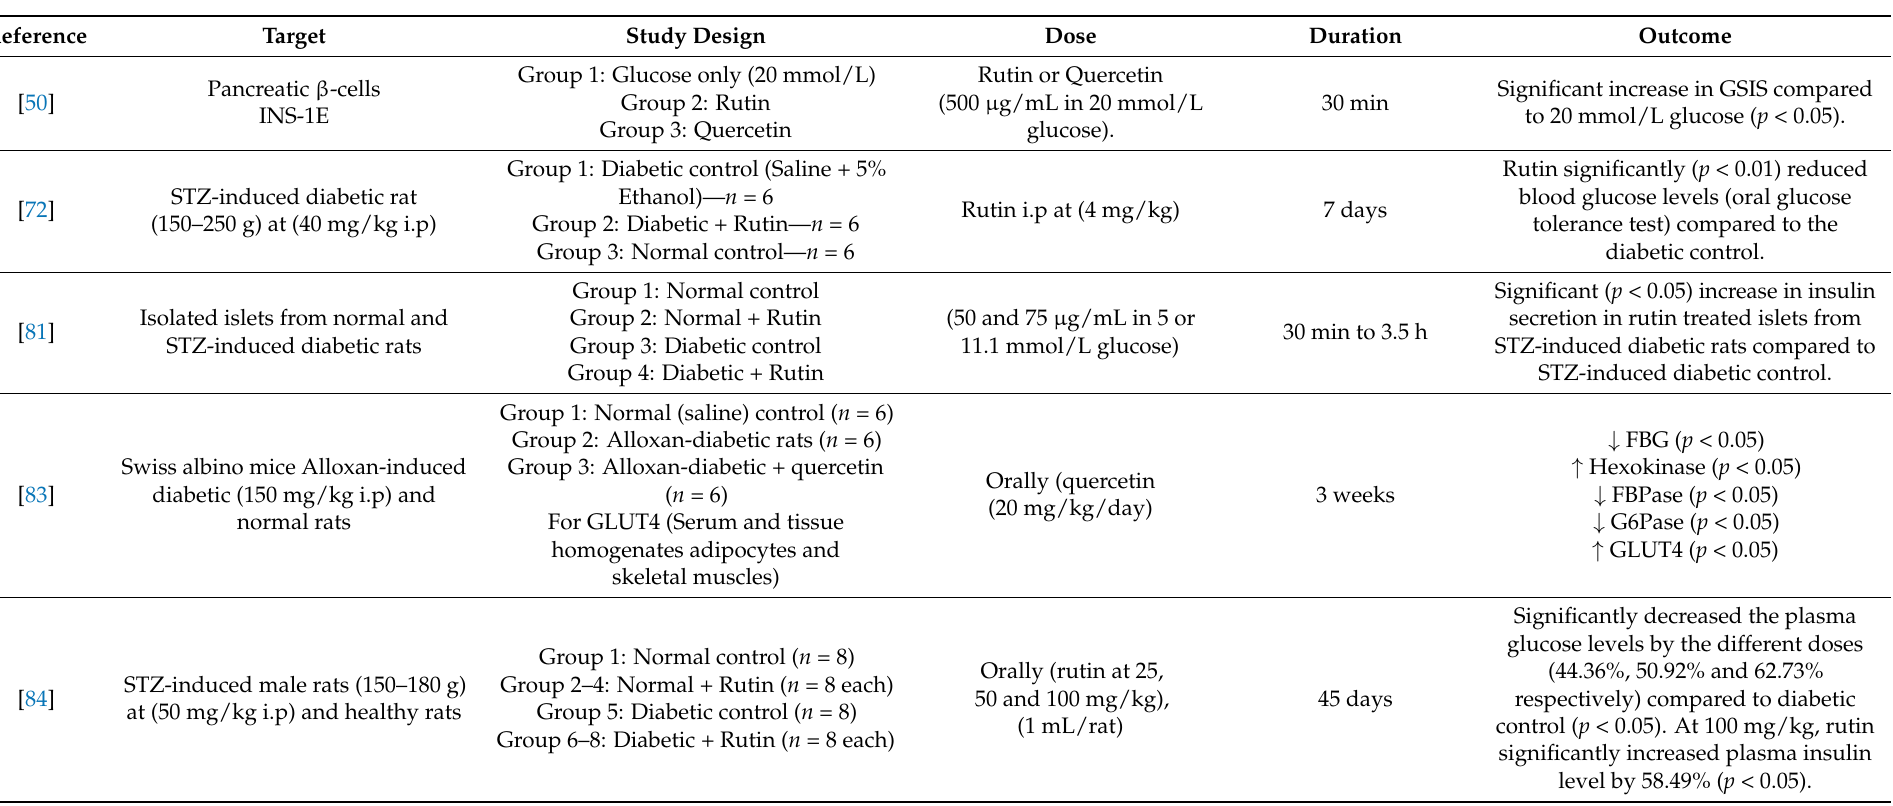
Table 4. Quercetin and rutin potential in lowering blood glucose